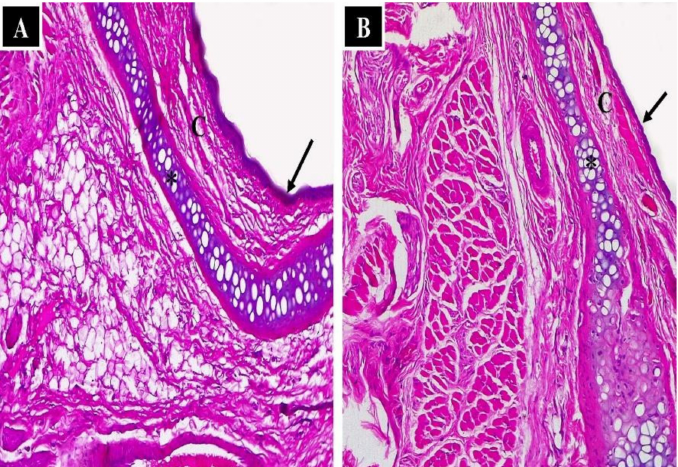
Figure 8. Light photomicrographs show ( A ) nasal epithelium of the control group (without any treatment) and ( B ) nasal epithelium of the GS-CBS in situ gel group. Notice normal nasal cartilage (*), normal nasal epithelium (arrows) and capillaries (C). H&E stain ×